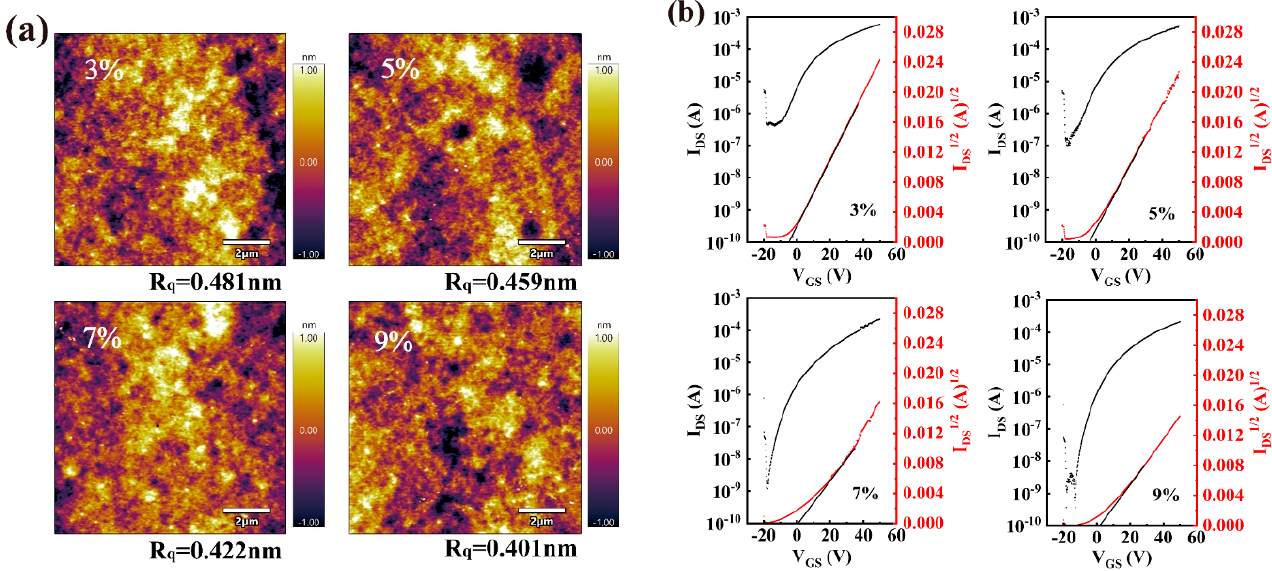
Figure 3. ( a ) AFM images of surface morphology of the In 2 O 3 /InGdO TFTs with different Gd concentrations. ( b ) Typical transfer curves of the In 2 O 3 /InGdO TFTs with different Gd concentrations at V DS = 10 V.